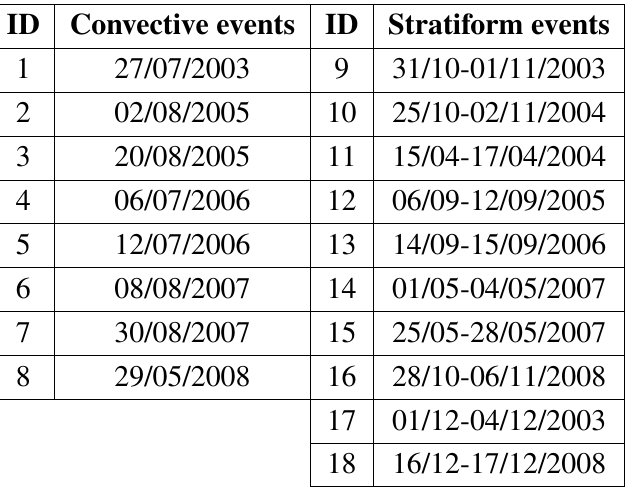
Table 1. Dates and codes of the selected events.